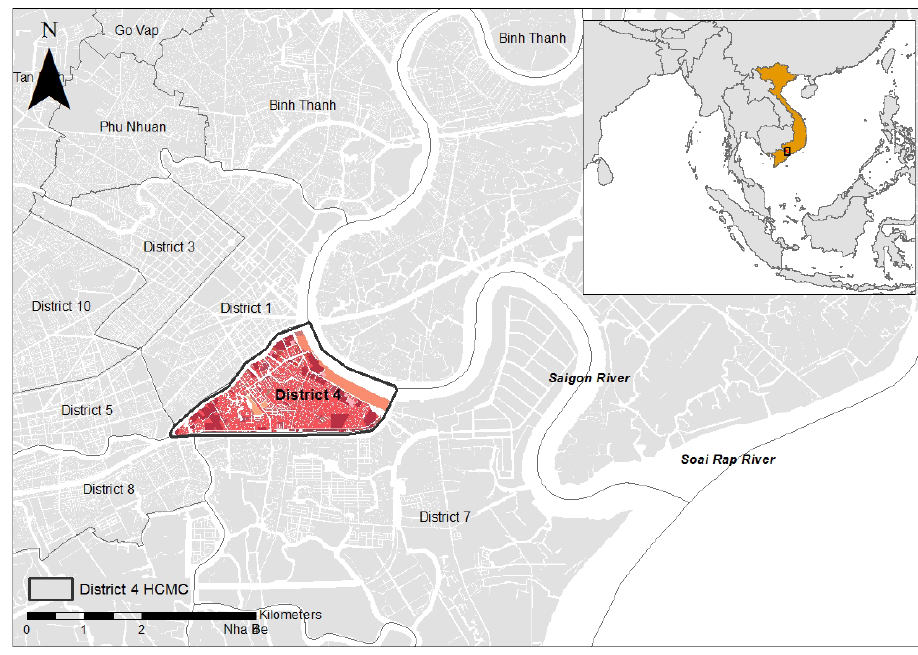
Figure 2. Map of the study area in Ho Chi Minh